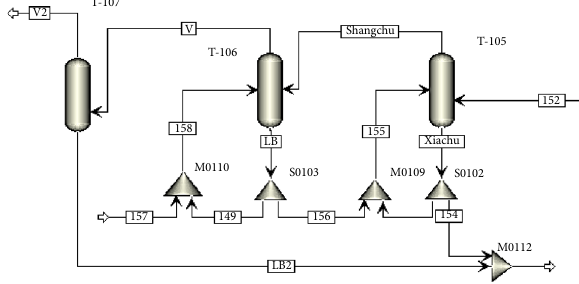
Figure 4: Process of three-tower dehydration.